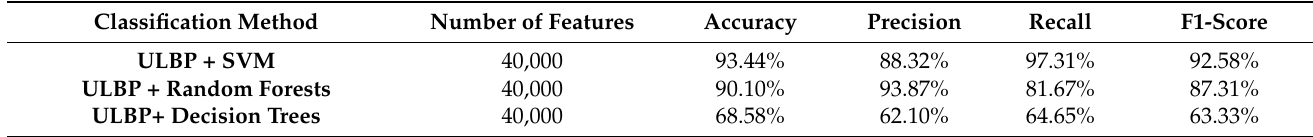
Table 5. Accuracy, Precision, Recall, and F1-scores using ULBP features.